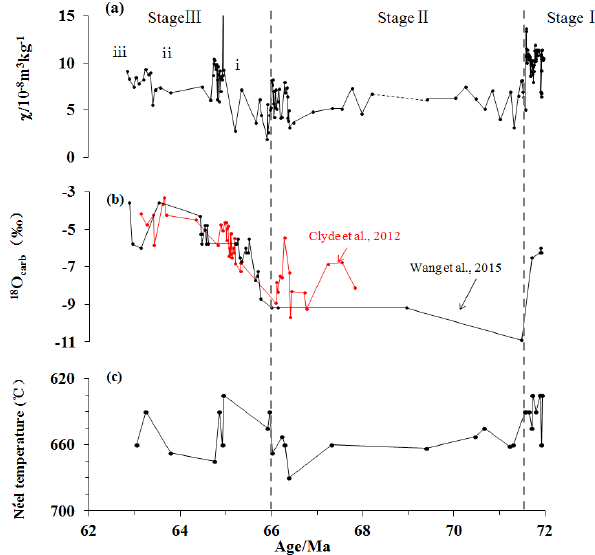
Figure 10. Combined proxies for palaeoclimatic changes in the Nanxiong Basin from 72 to 62.8Ma, (a) χ curve, (b) δ 18 O of pe- dogenic carbonates (Clyde et al., 2010; Wang, 2012), and (c) T N of Al-substituted haematite in pilot